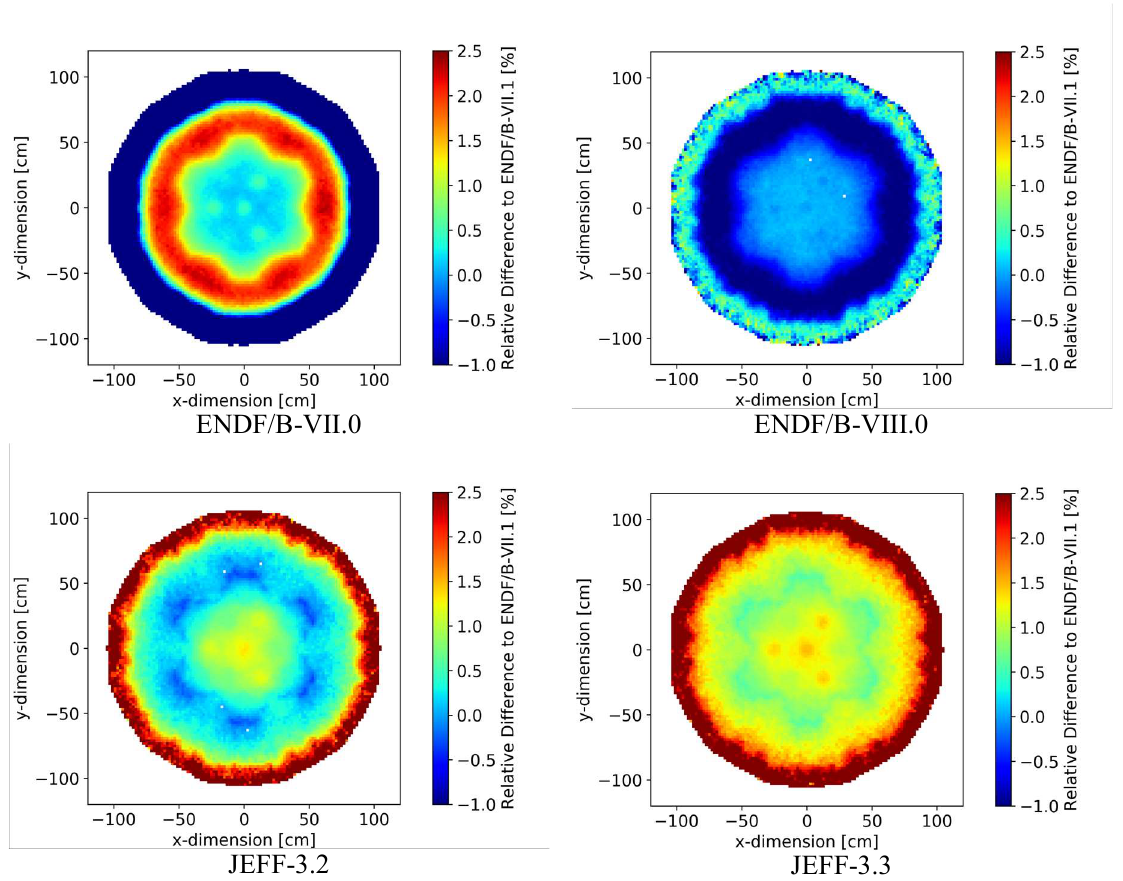
Figure 4. One-group Flux Relative Differences from Reference ENDF/B-VII.1